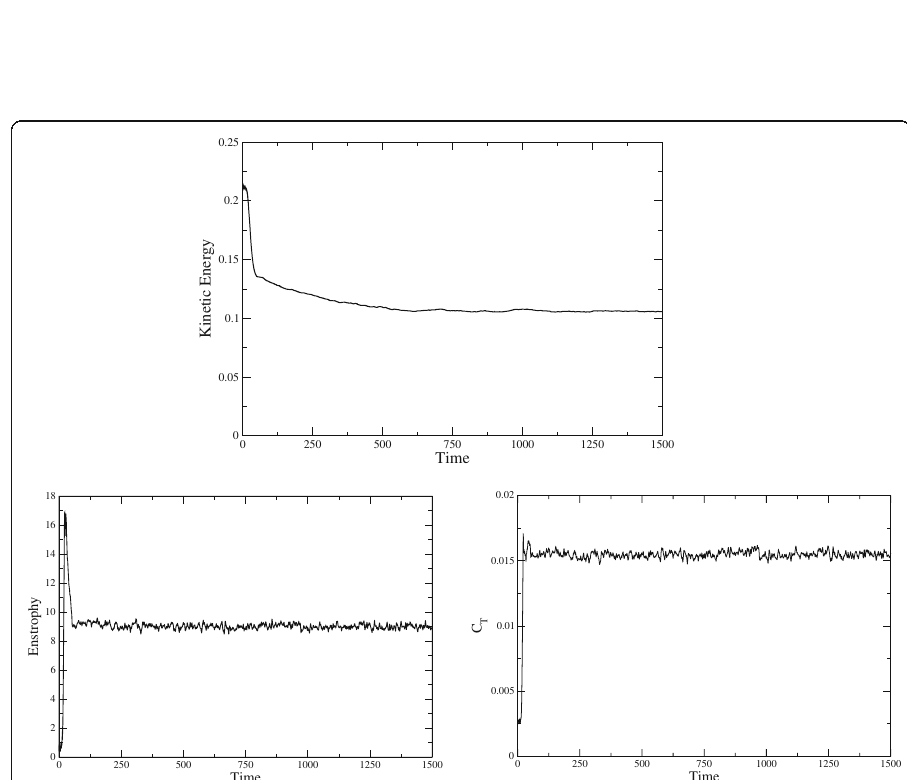
Fig. 9 Histories of non-dimensional kinetic energy, enstrophy and torque coefficient in a long-term